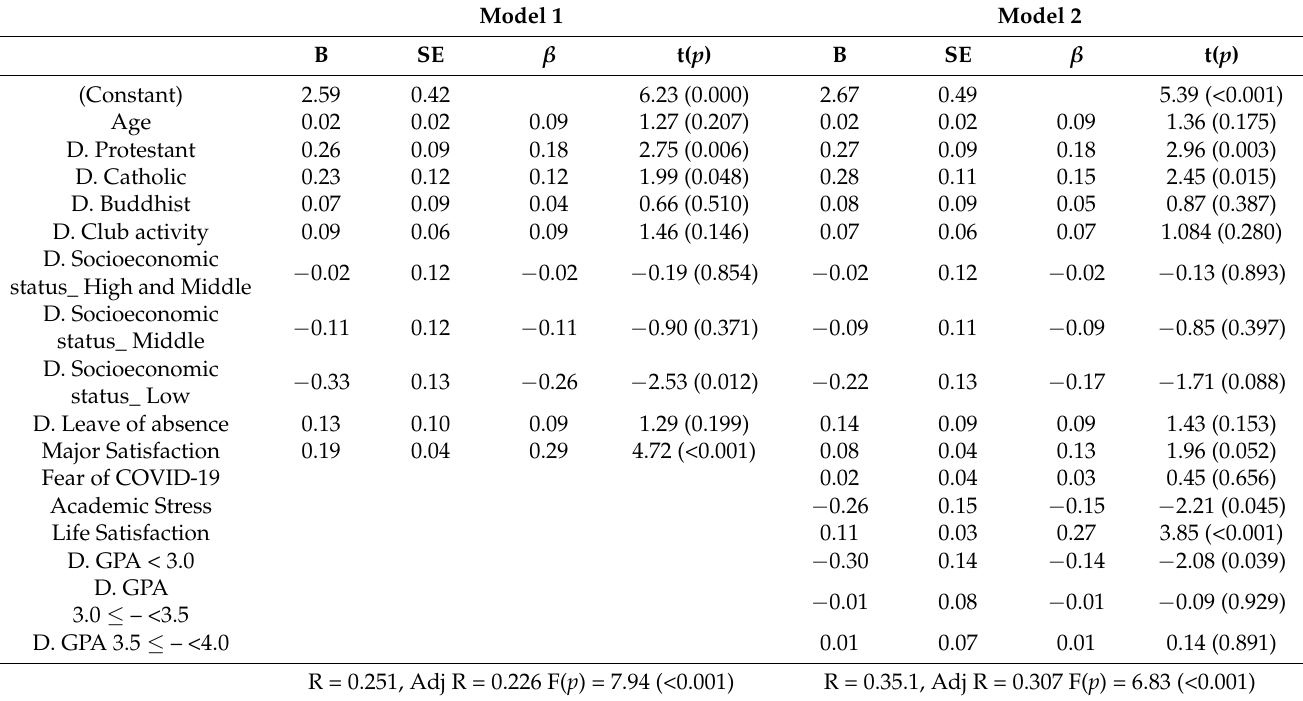
Table 4. Factors affecting spiritual health among nursing students ( N =